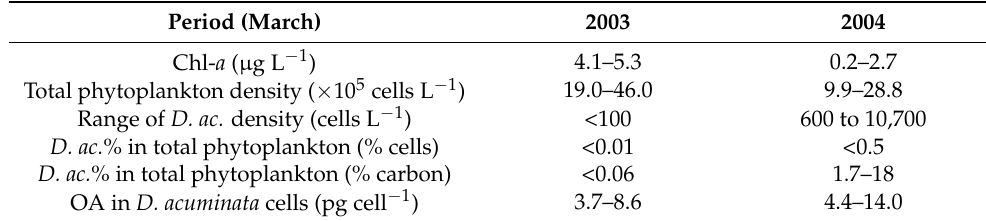
Table 1. The range of Chl- a , phytoplankton density and D. acuminata parameters over the sam- pling